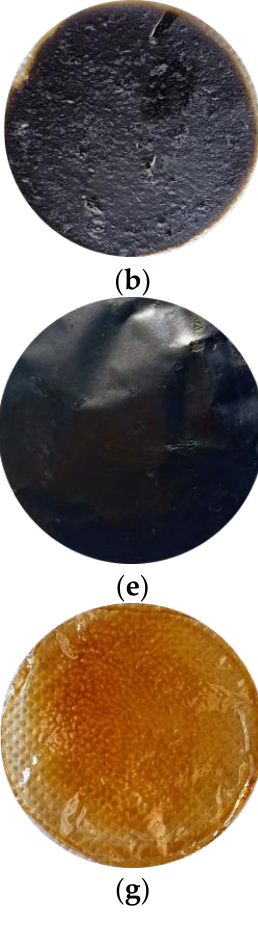
Figure 2. Macroscopic appearance of the prepared membranes: ( a ) GO/PBI 1:3; ( b ) GO/PBI 1:2; ( c ) GO/PBI 1:1; ( d ) GO/PBI 2:1; ( e ) GO/PBI 3:1; ( f ) pure GO; ( g ) pure PBI.